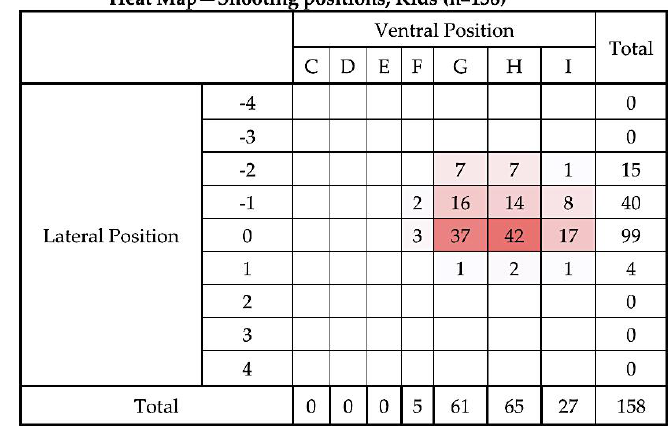
Figure 7. Heat map of the distribution of application positions (right-handed operative) for the remaining 158 kids. Colour intensity is related to number of applications in each location. Lateral target area, with 0 representing the midline based on the suture of the paired frontal bones with positive values to the LHS and negative values to the RHS of the head (see Figure 3). Ventral targeting areas using surface topography with F representing a shot on the frontal–parietal suture, G on the parietal bone, H on the parietal–occipital suture, etc. with C rostral to the head (see Figure 4).